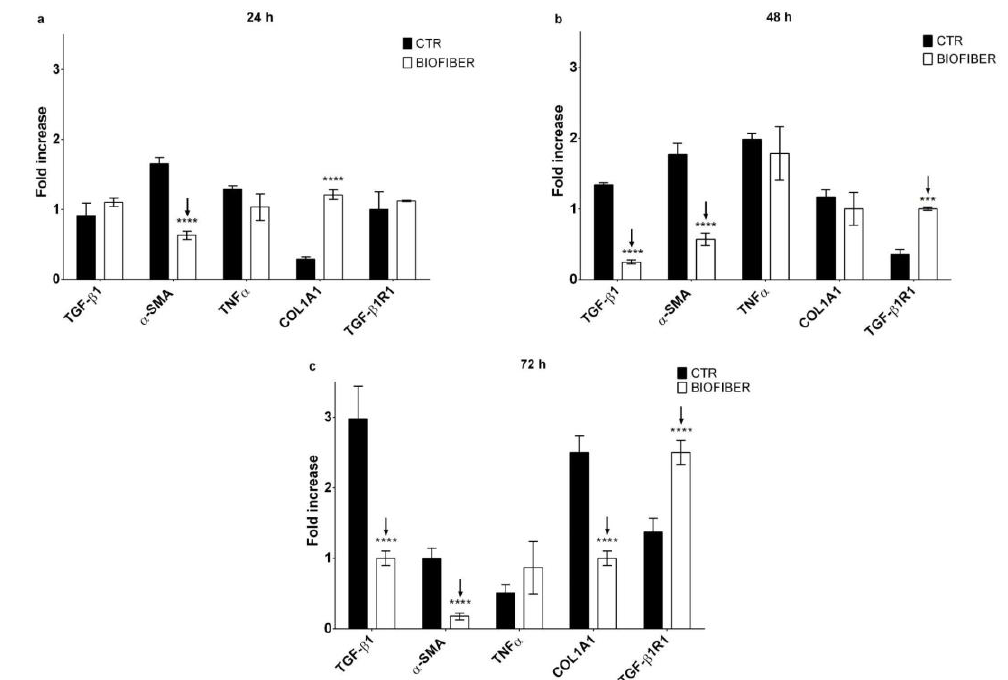
Figure 11. Gene expression analysis of NHDF treated with Biofiber for 24, 48, and 72 h. ( a ) qRT-PCR at 24 h. ( b ) qRT-PCR at 48 h. ( c ) qRT-PCR at 72 h. Results are normalized to the housekeeping gene (Glyceraldehyde-3-Phosphate Dehydrogenase (GAPDH)). Statistically significant values are indicated as *** p < 0.001, **** p < 0.0001. Analysis of variance test was performed to evaluate data significance.